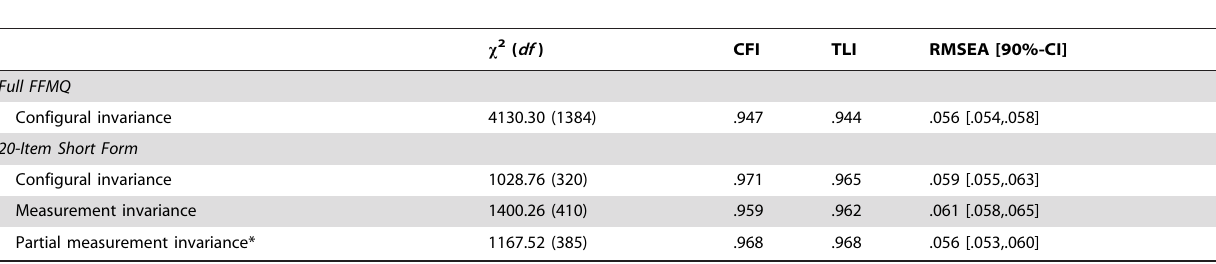
Table 2. Fit of Five-Factor Multigroup Models on All Five